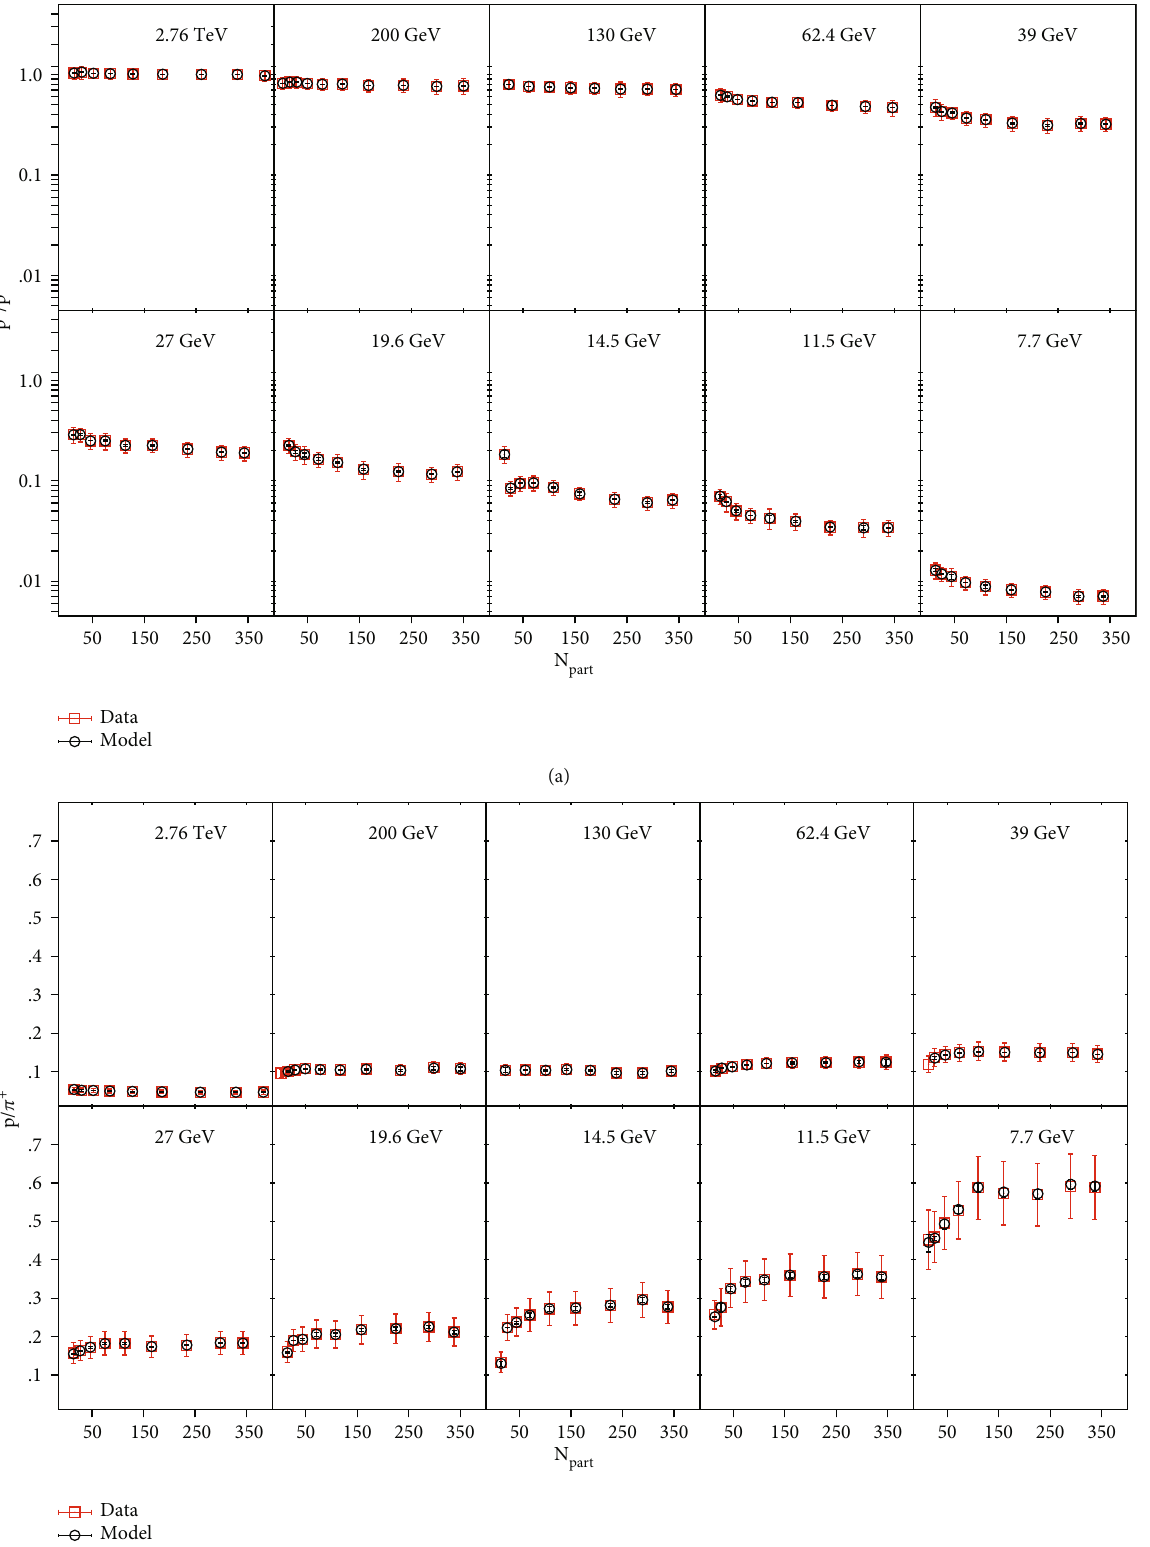
p ffiffiffiffiffiffiffiffi . Experimental data (red) are from s NN